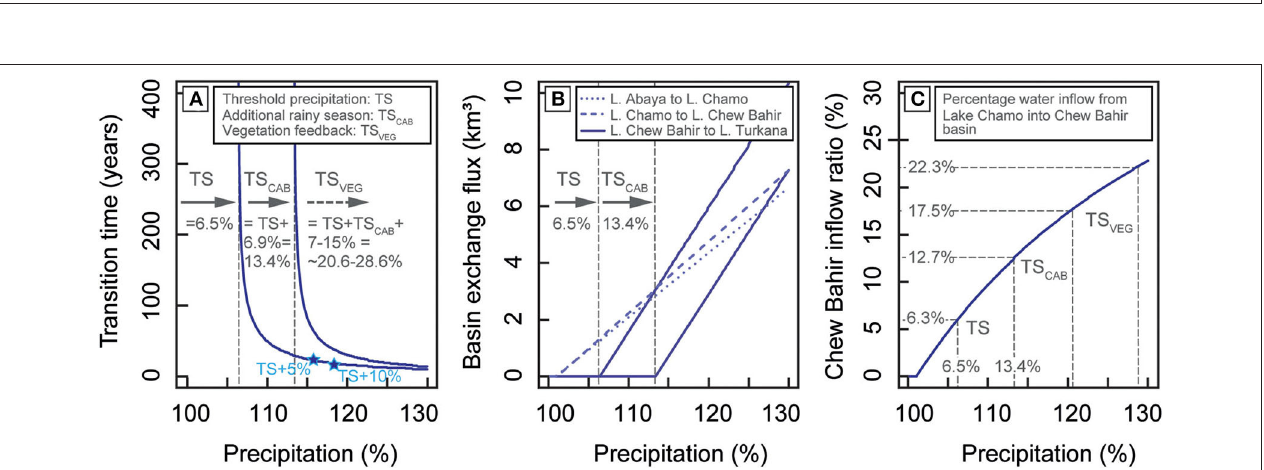
FIGURE 4 | SEBAL results for paleo-lake Chew Bahir catchment: (A) Map of actual evaporation distribution throughout the catchment. (B) Monthly precipitation and monthly water balance of the Chew Bahir catchment.